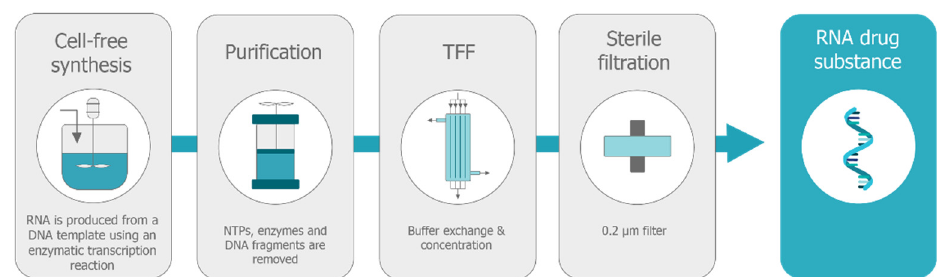
Figure 8. Schematic diagram of the manufacturing process for the RNA drug substance. The process involves a cell-free enzymatic in-vitro transcription reaction followed by purification to remove the DNA template, followed by tangential flow filtration (TFF) for buffer exchange and concentration, followed by sterile filtration through a 0.2 µ m filter.